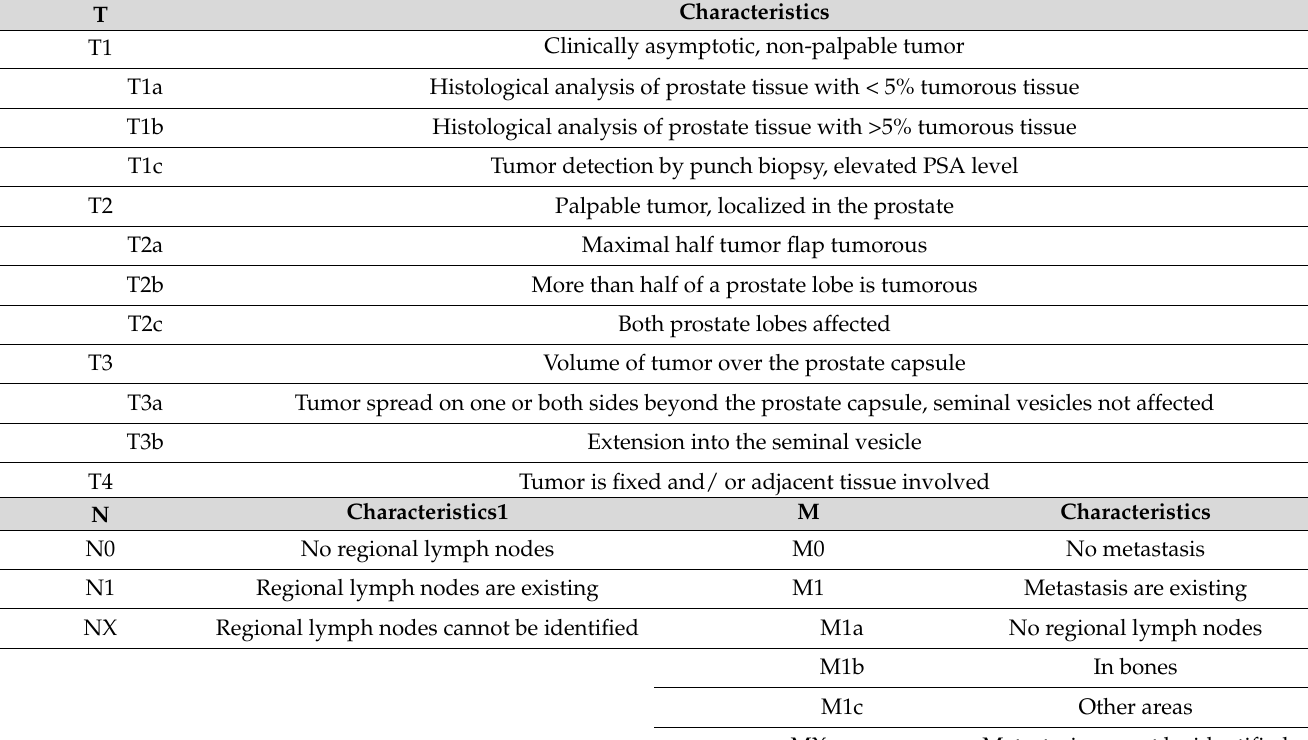
Table 1. Classification of prostate cancer stage (TNM; T= volume of tumor; N= involvement of lymph nodes; M= metasta- sis